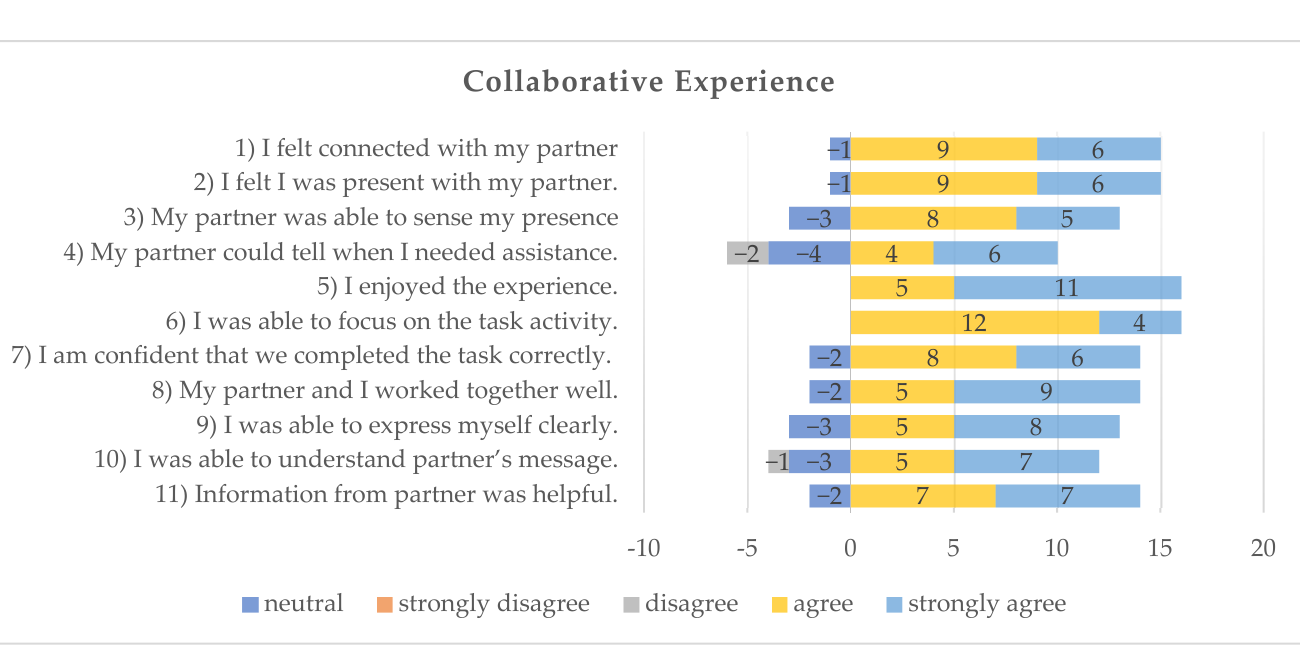
Figure 8. Distribution of users’ prior collaborative experience.